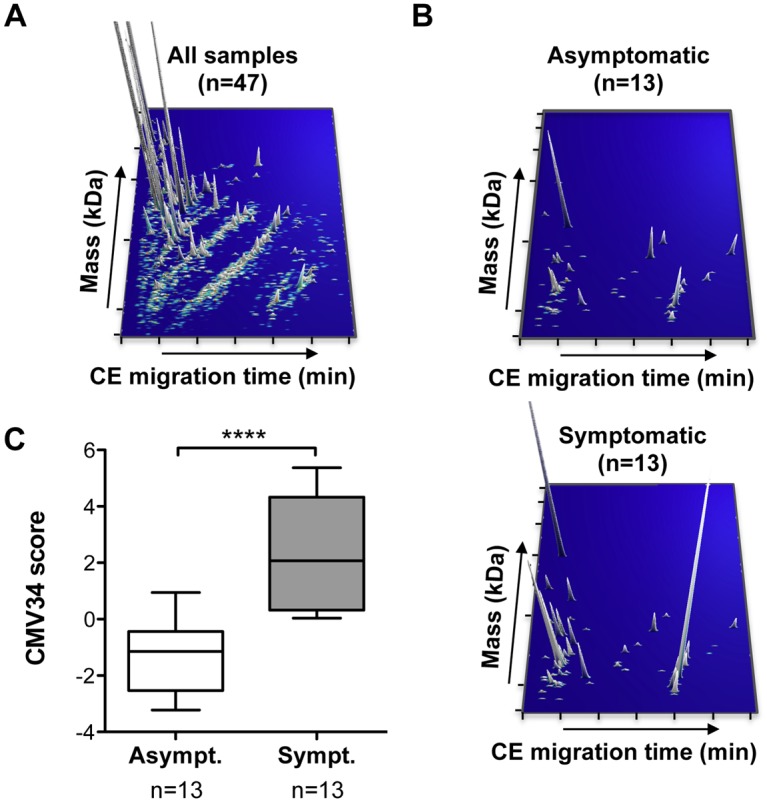
Detected peptides in amniotic fluid and differences between symptomatic and asymptomatic cases in the discovery cohort.(A) Representation of 4076 peptides, detected in all amniotic fluid samples (n = 47) by CE-MS. Each peptide was identified by a unique identifier based on the migration time (min) and specific mass (kDa), with a peak height representing the relative abundance. (B) In the discovery cohort, 76 amniotic fluid peptides were identified as differentially secreted between symptomatic and asymptomatic patients. (C) Cross-validation score of a SVM peptide classifier called CMV34 consisting of 34 of the 37 sequenced peptides obtained from the analysis of the discovery cohort. ***p<0.0001, Mann-Whitney test for independent samples. Asympt., asymptomatic; Sympt., symptomatic.